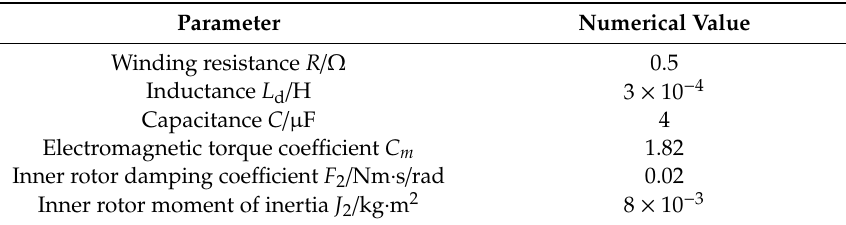
Figure 5. Relationship between the effective value of induced potential and slip. Table 2. Speed regulation model parameters of PMSC.